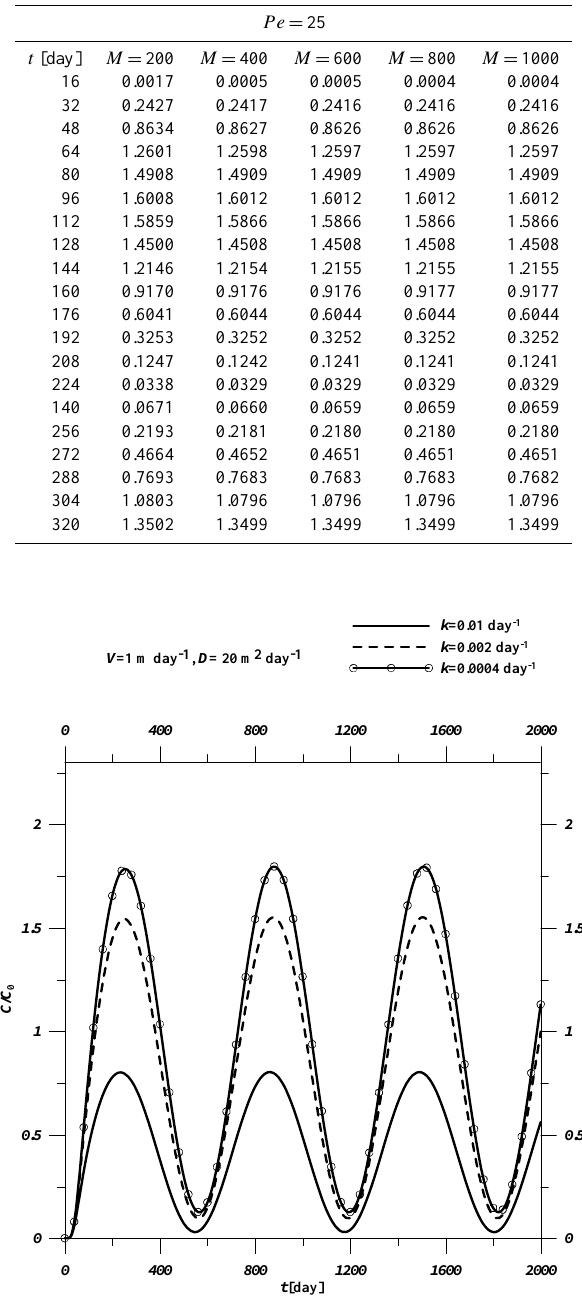
Fig. 3. Comparison of the breakthrough curves at x = 100 m for Fig. 3 different k . The sinusoidally periodic input function is f (t) = 1 + sin t . Parameter k is varied and other parameters are kept constant.